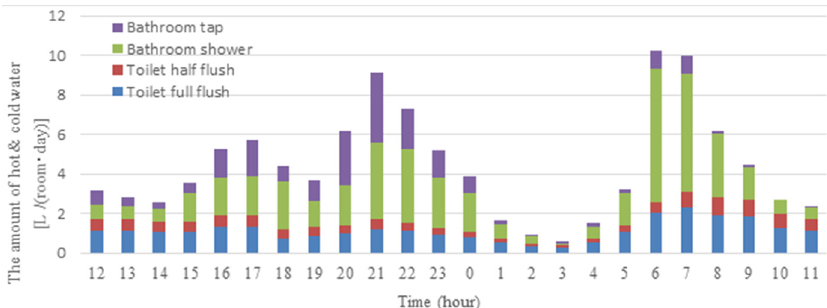
Figure 5. The breakdown of the hourly hot and cold water use.